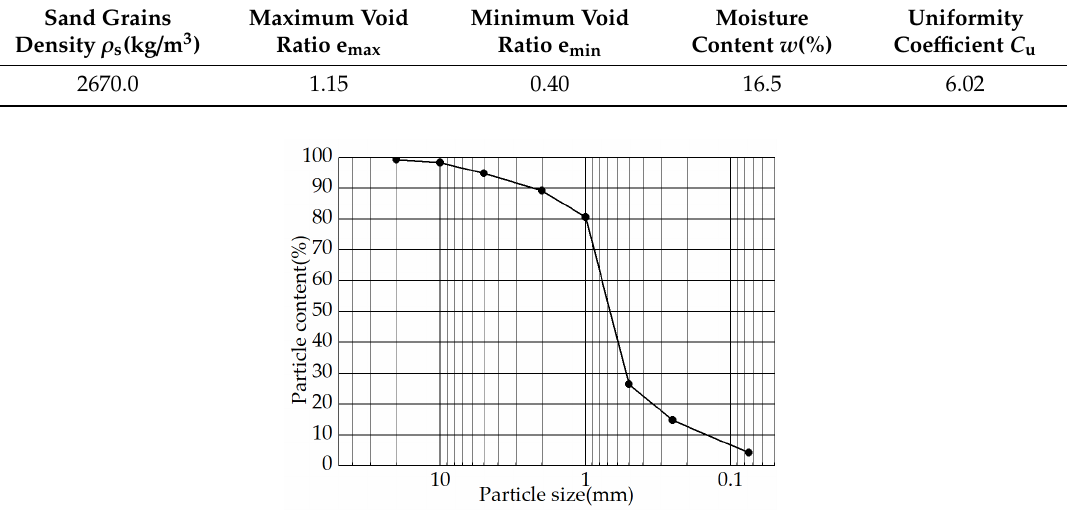
Figure 4. Event introduction of Pingkan tunnel. (a) Location of Pingkan tunnel [21]; (b) Water–sand inrush disasters in Pingkan tunnel. Table 1. Physical parameters of the soil sample.